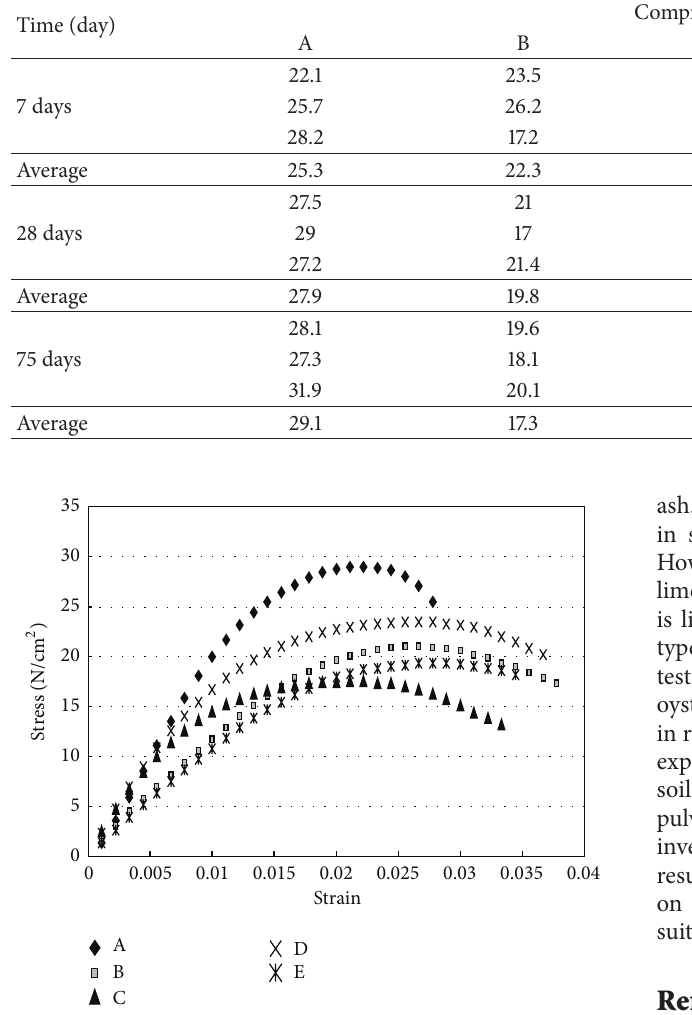
Figure 12: Stress and strain of the compacted soil at 28